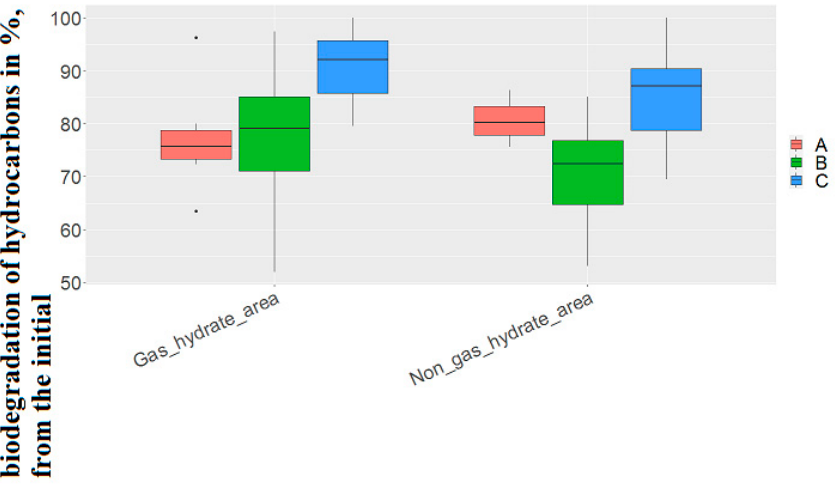
Figure 7. Biodegradation of hydrocarbons by strains isolated from gas-hydrate region and non-gas-hydrate region. (A) The degree of biodegradation of oil by strains capable of utilizing oil only under aerobic conditions; (B) the degree of oil biodegradation by strains capable of utilizing oil both under aerobic and anaerobic conditions (aerobic conditions); (C) the degree of oil biodegradation by strains capable of utilizing oil both under aerobic and anaerobic conditions (anaerobic conditions).